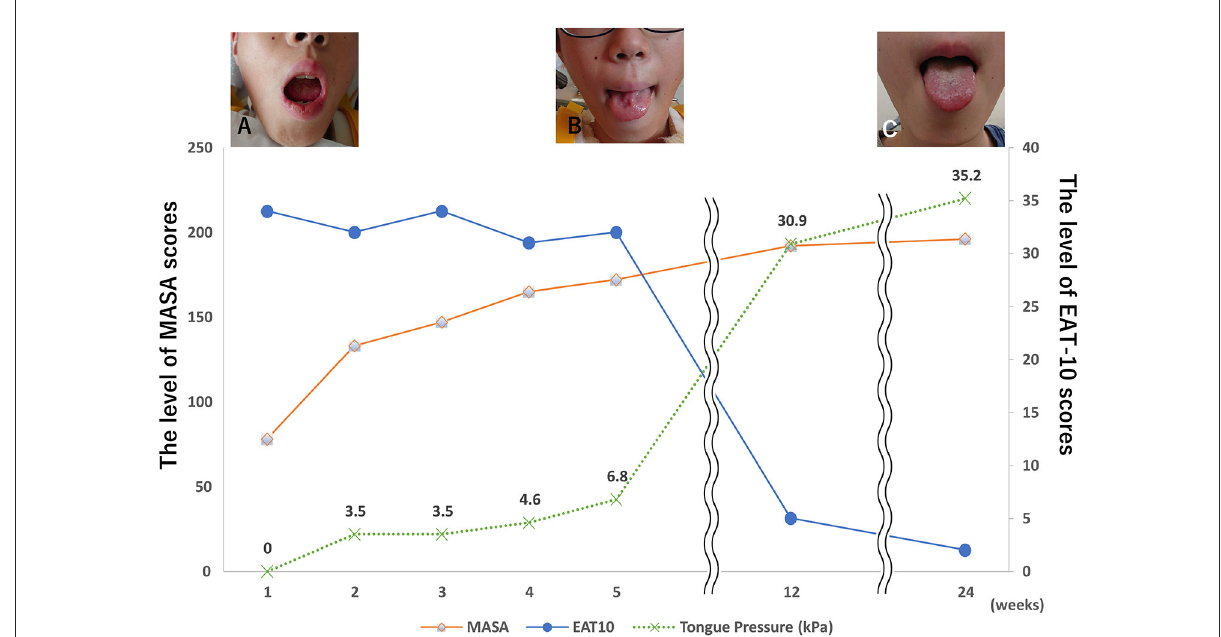
FIGURE1 Image inspection. (A) A cervical X-ray shows atlanto-occipital dislocation, (a) space available for the cord is 23.02mm, (b) atlanto-dental interval is 4.64mm. (B) A cervical computed tomography scan shows an acute epidural hematoma in front of the medulla oblongata (red arrow). (C) An arterio-venous shunt runs from the dorsal side of the clivus to the sublingual branch (the neuro-meningeal branch of the left ascending pharyngeal artery) to the right cavernous sinus.